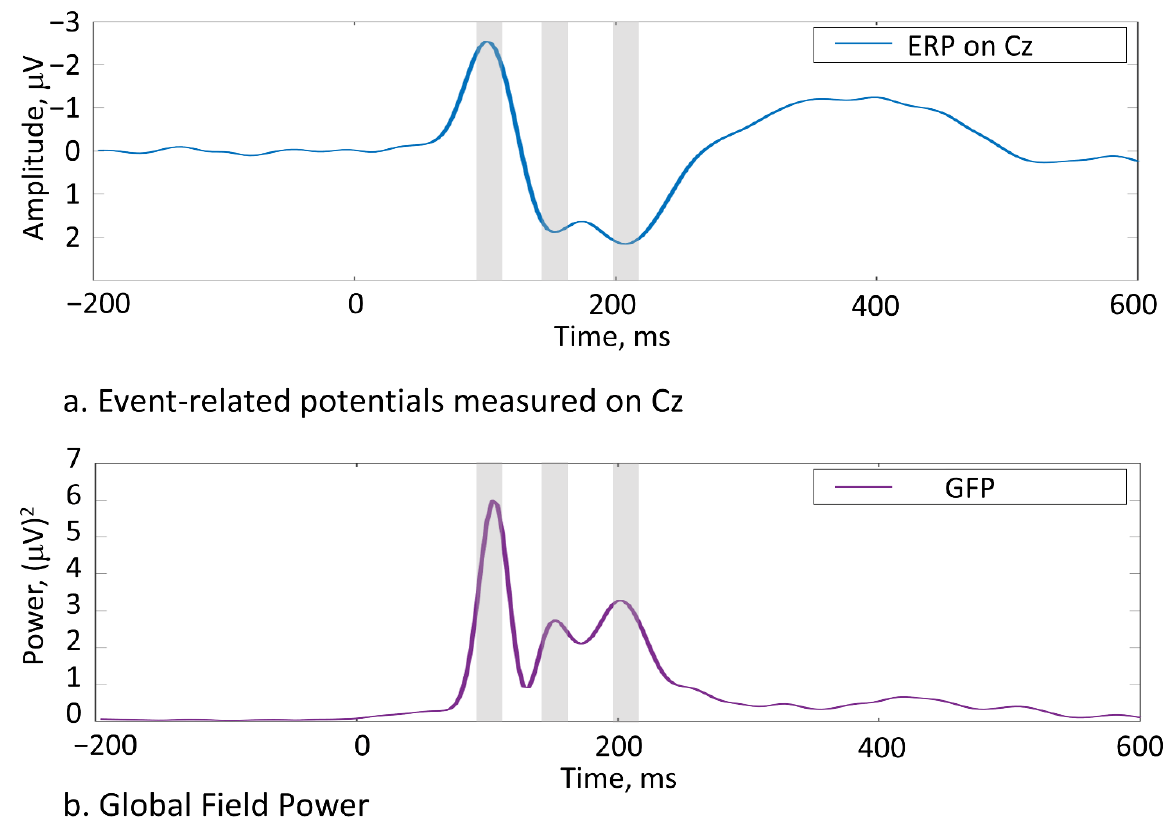
Figure 2. Event-related potentials (Cz electrode) and global field power (GFP; all electrodes) computed across all stimulus conditions and subjects identified the most prominent peaks at around 106, 146, and 206 ms (highlighted).